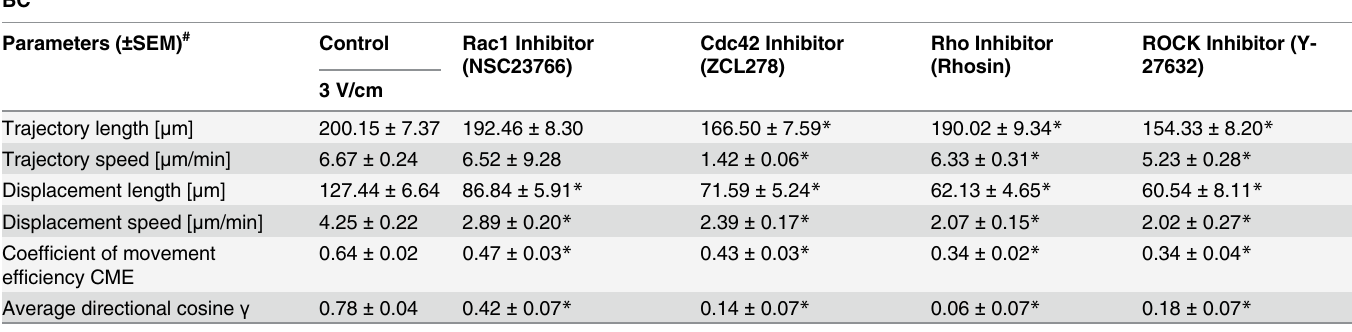
Table 4. Quantitative data showing the effects of Rac, Cdc42, Rho and ROCK inhibitors on electrotaxis of BC cells. BC